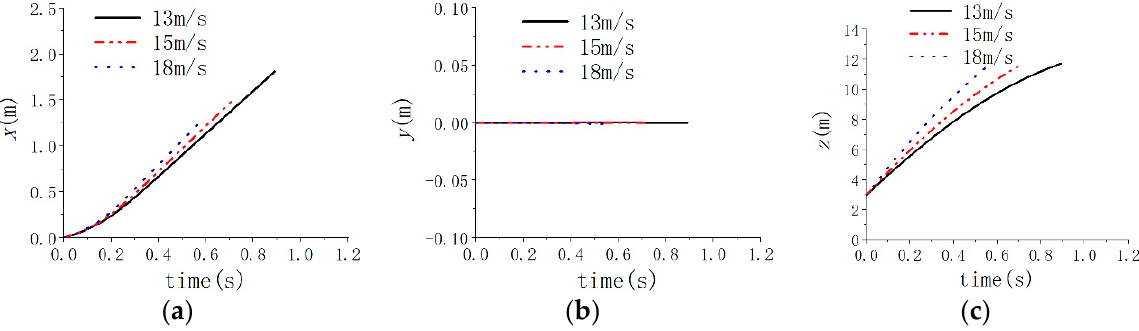
Figure 13. Streamline diagram of vehicle flying out of water in case 3.